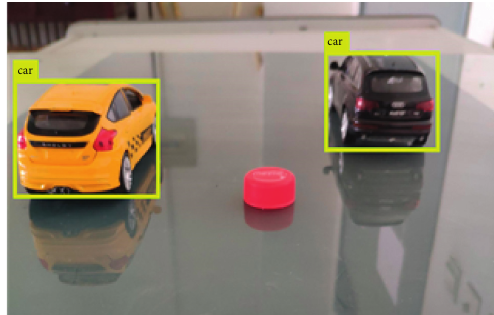
Figure 18: Faster RCNN identification effect